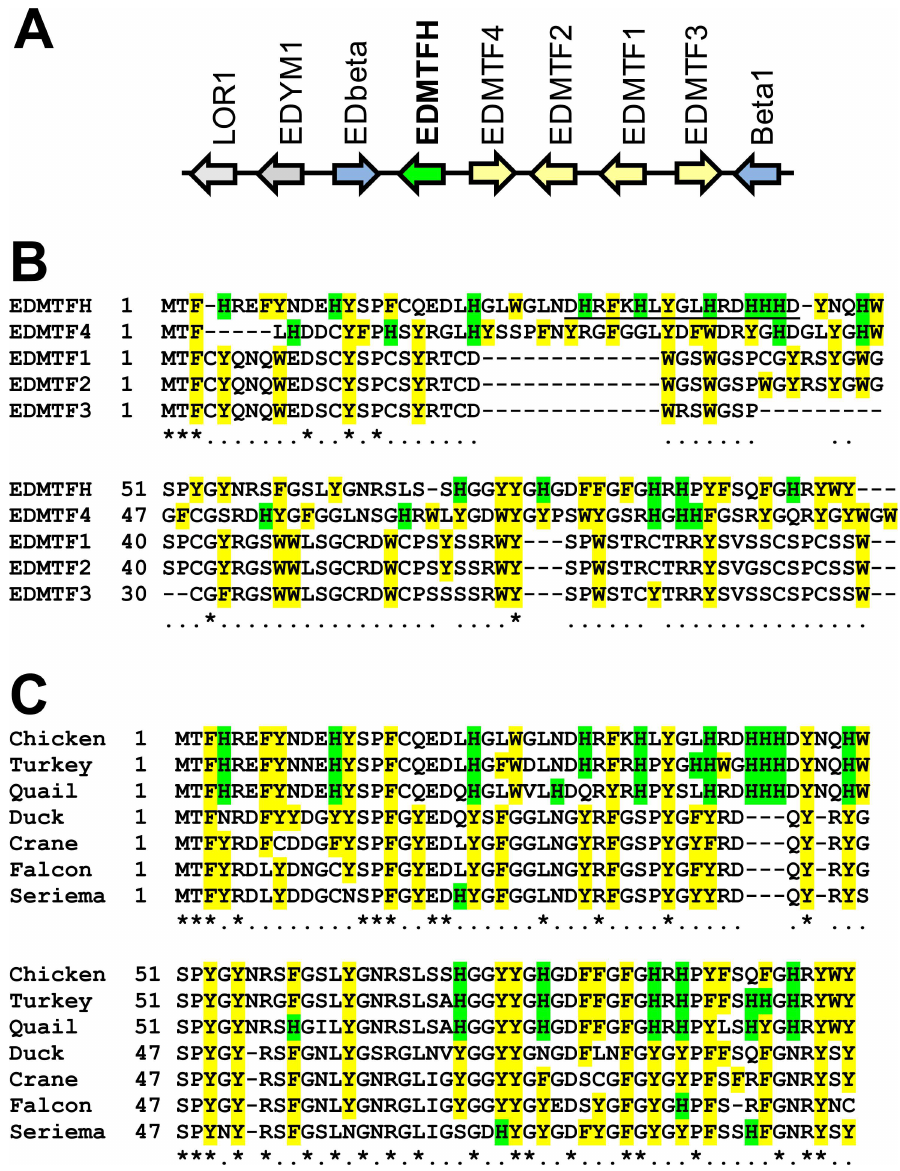
Fig 2. Comparison of chicken EDMTFH versus other EDMTF proteins of the chicken and homologs in other species. ( A ) EDMTFH gene locus in the chicken. Arrows indicate the origientationof gene transcription. The genes EDbeta and Beta1 (preliminary names [13]) encodecorneousbeta-proteins (CBPs), also known as beta-keratins. ( B ) Amino acid sequencealignmentof EDMTFH versus other chicken EDMTF proteins. The peptideused as an epitopefor raisingthe anti-EDMTFH antibodyis underlined. ( C ) Amino acid sequencealignment of chicken EDMTFH versus the most similar proteins of other birds. Formats in ( B ) and ( C ) indicatethe following:Histidine(H) residuesare highlightedby green shading, other aromatic residues are highlightedby yellow shading. Numbers indicate amino acid sequencepositions.Identity of residuesin all sequencesis indicatedby an asterisk and conservation in at least 50% of the sequencesis indicatedby "." belowthe alignments. Hyphenswere introduced to maximize the alignmentof the sequences.Sequences